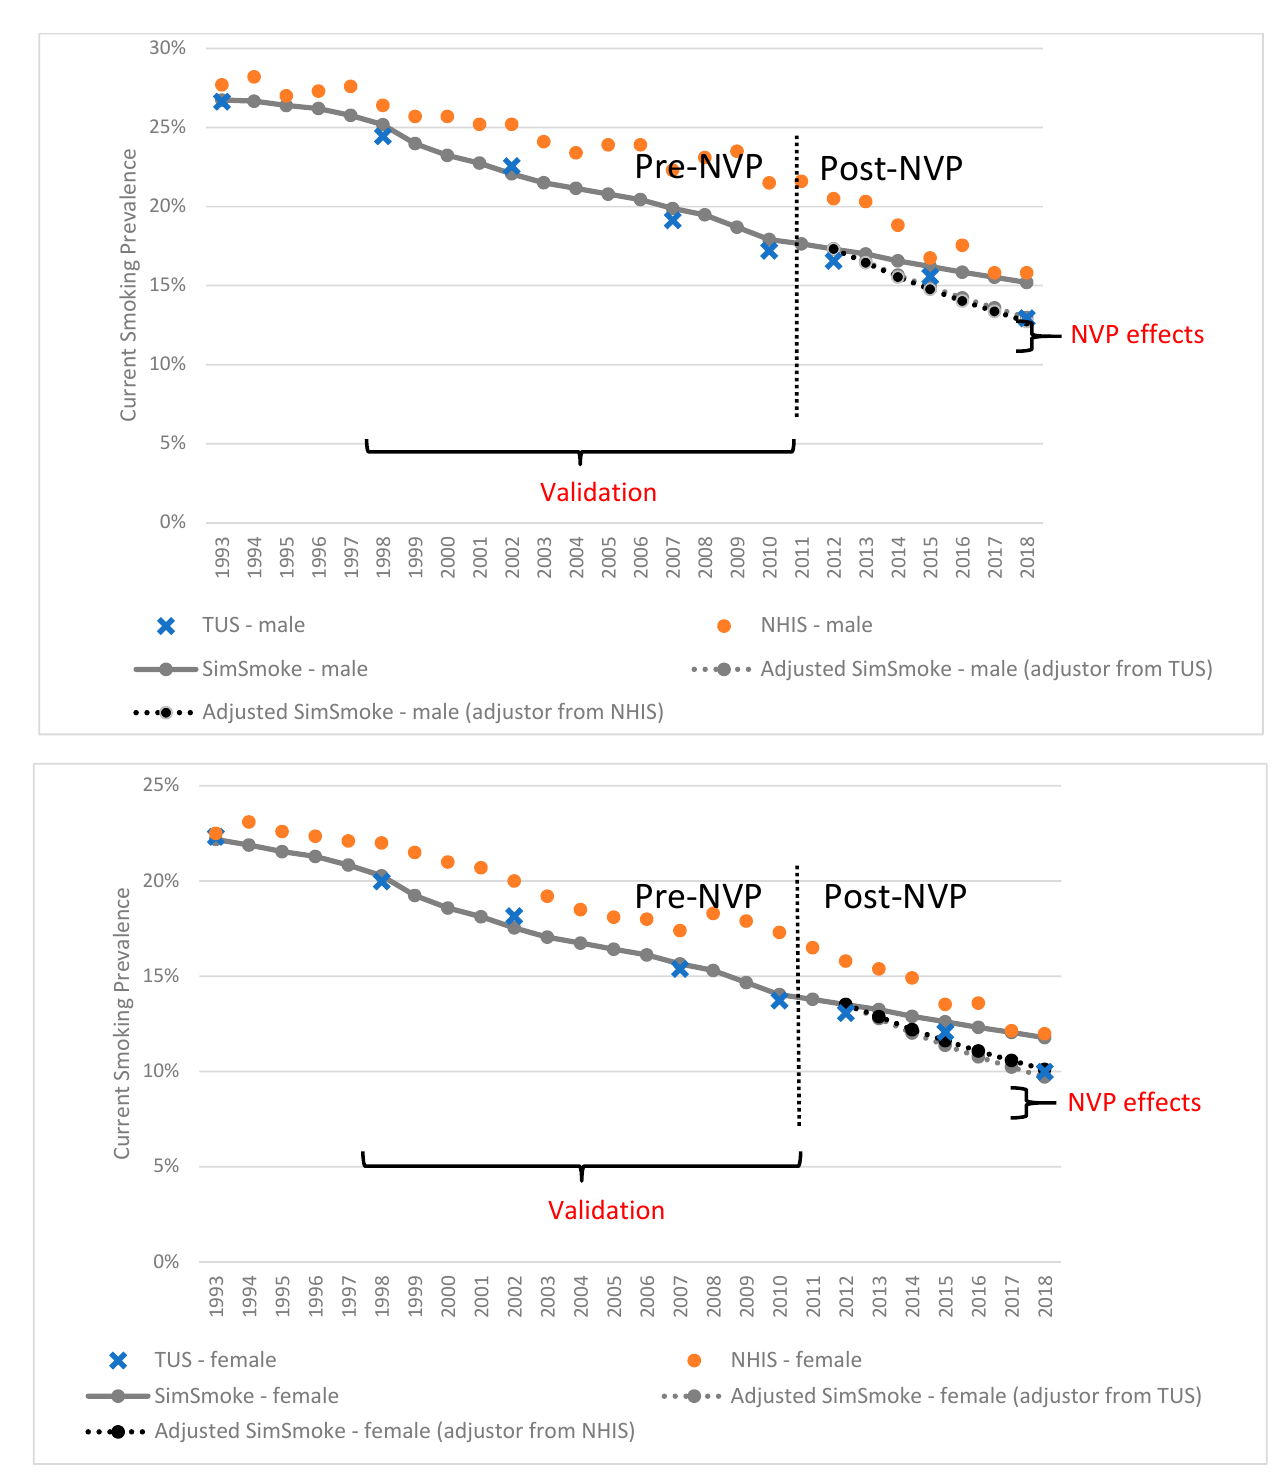
Figure 1. Smoking prevalence in surveys and the SimSmoke model with/without the NVP adjustors by sex, ages 18 and above, 1993–2018.